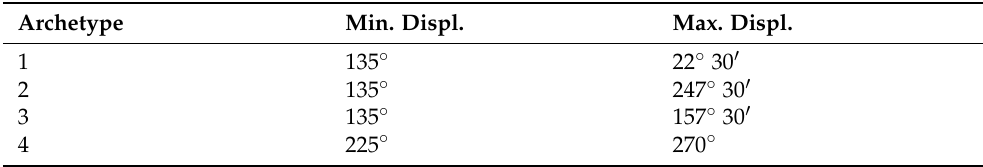
Table 8. Summary of the angles of incidence that produce the maximum and minimum roof displace- ment on the archetypes, SRSS